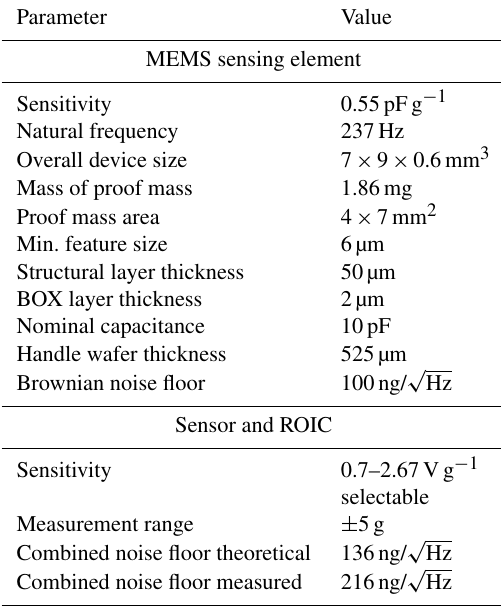
Table 3. Parameters of the accelerometer.